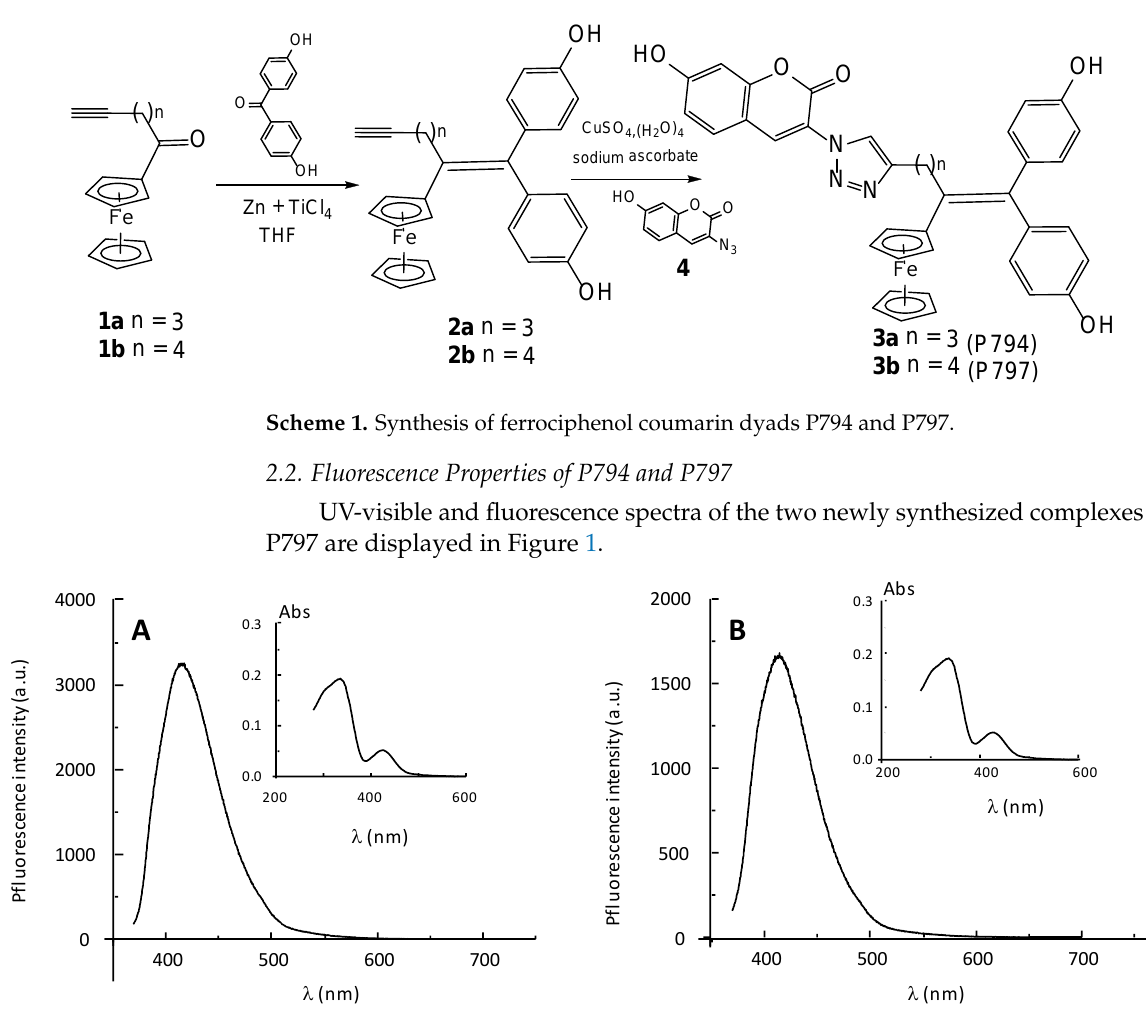
Figure 1. UV-vis absorption (insets) and fluorescence emission spectra of P797 (( A ) left graph) and P794 (( B ) right graph) at 1 × 10 − 5 mol.dm − 3 in acetonitrile + TBABF 4 at 0.1 mol.dm − 3 . Excitation wavelength ( λ ex ) = 350 nm for fluorescence spectra.